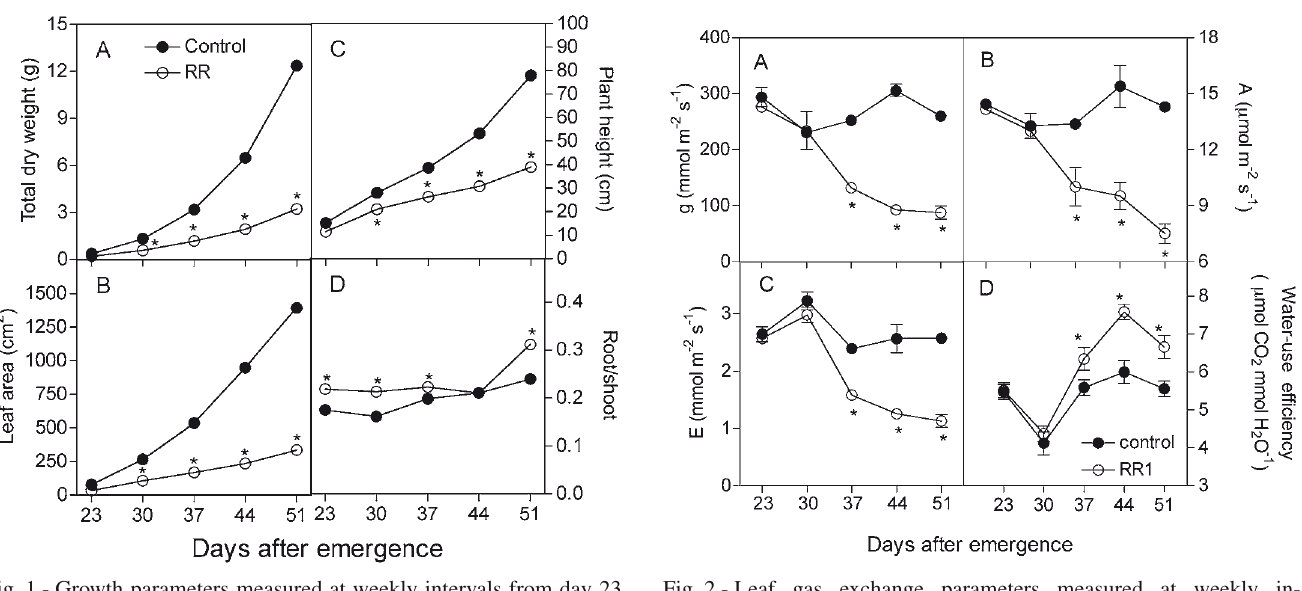
Fig. 2 - Leaf gas exchange parameters measured at weekly in- tervals from day 23 to the end of the experiment in both control and root-restricted (RR) plants: stomatal conduc- tance (A), net CO assimilation (B) and transpiration (C). 2 * indicates significantly different values for P≤0.05 (n=5), when means were separated by Duncan’s